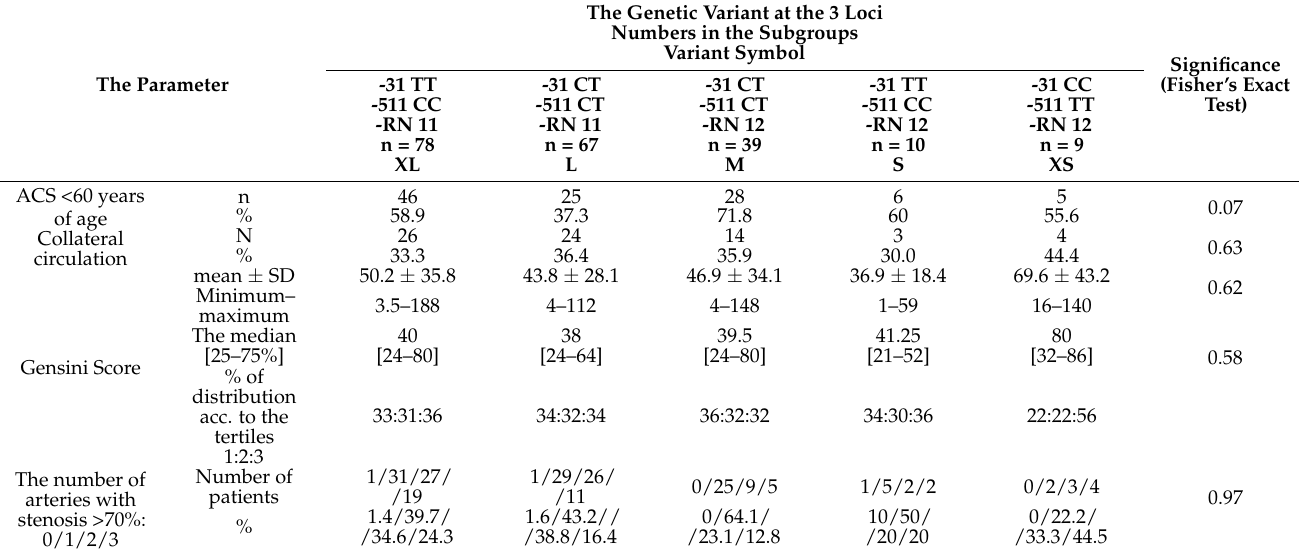
Significance (Fisher’s Exact Test)-31 TT